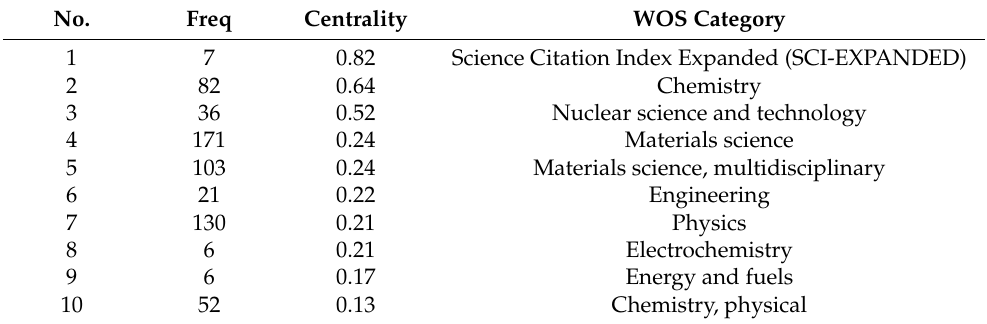
Table 2. Top 10 WOS category nodes according to centrality.